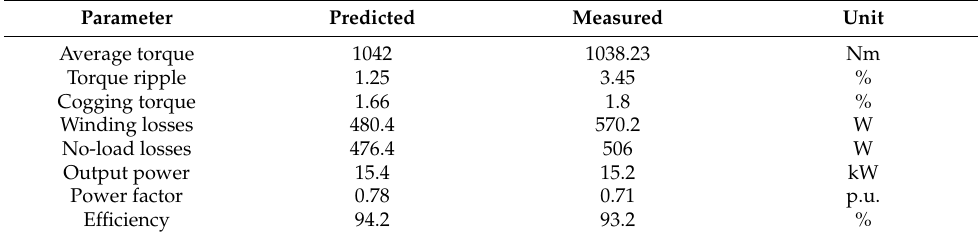
Table 8. FEA results comparison with the